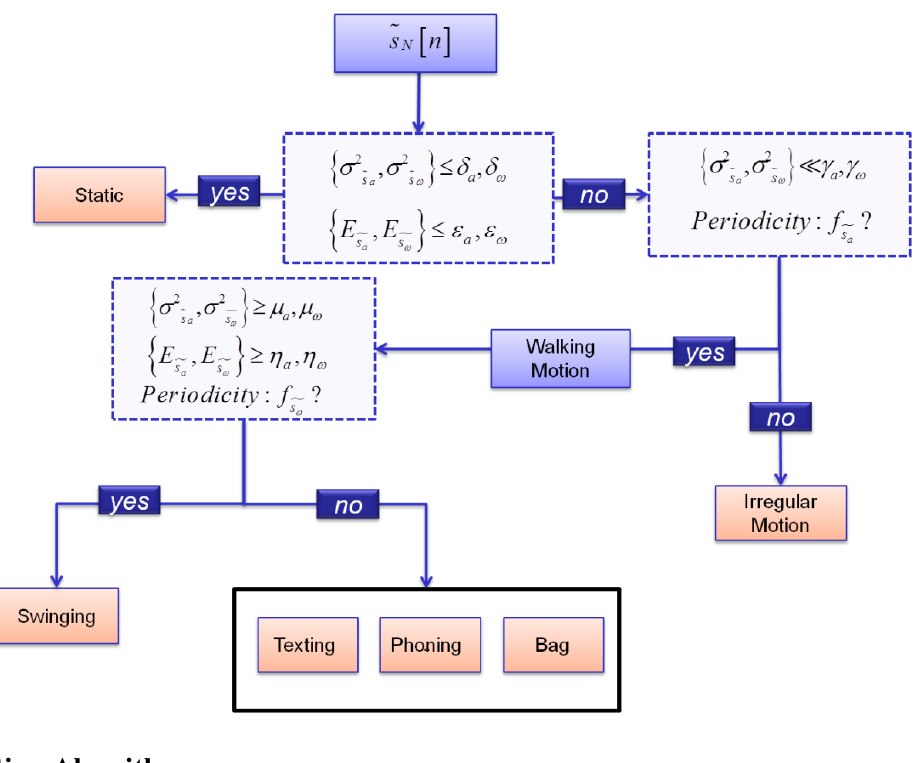
Figure 7. Decision tree for motion mode